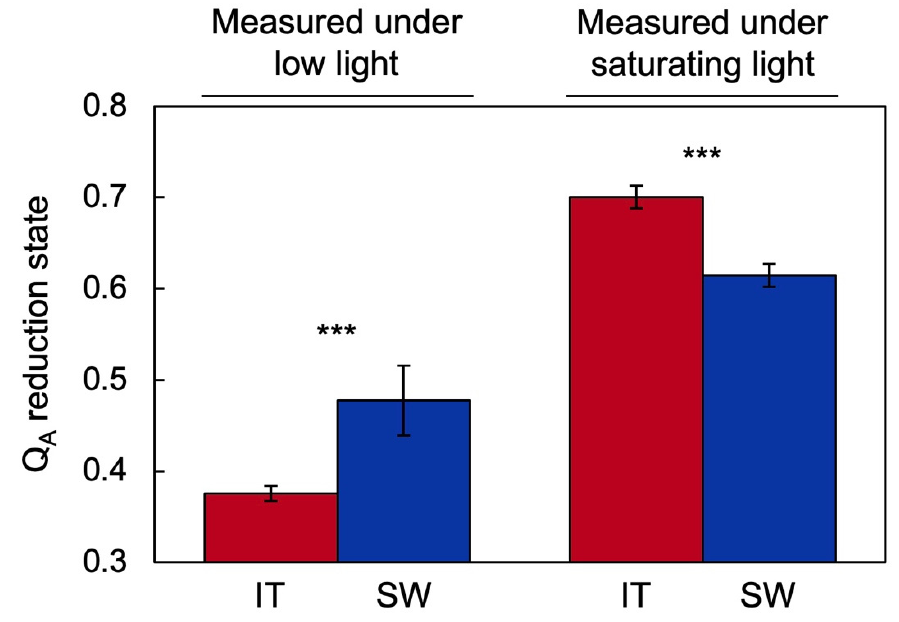
Figure 6. Excitation pressure as assessed from the reduction state of the primary electron acceptor Q A of photosystem II (via chlorophyll fluorescence [77]) measured under either low light (50 µmol photons m − 2 s − 1 ) or saturating light (2000 µmol photons m − 2 s − 1 ) in IT (red columns) and SW (blue columns) grown under cool temperature and high light. Mean values ± standard deviations ( n = 3); statistically significant differences between ecotypes based on Student’s t -tests are indicated with asterisks (*** = p < 0.001). Data from [52].